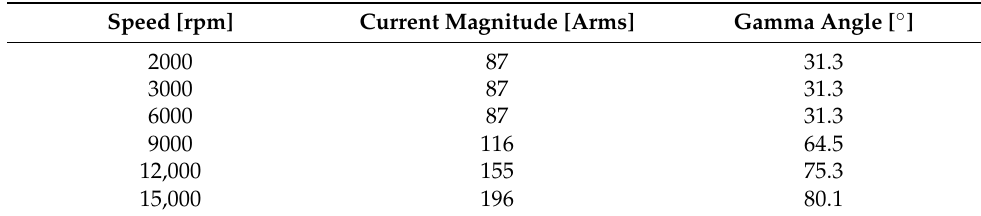
Table 5. Current magnitude and phase (gamma) angle at 20% peak torque for six speeds.